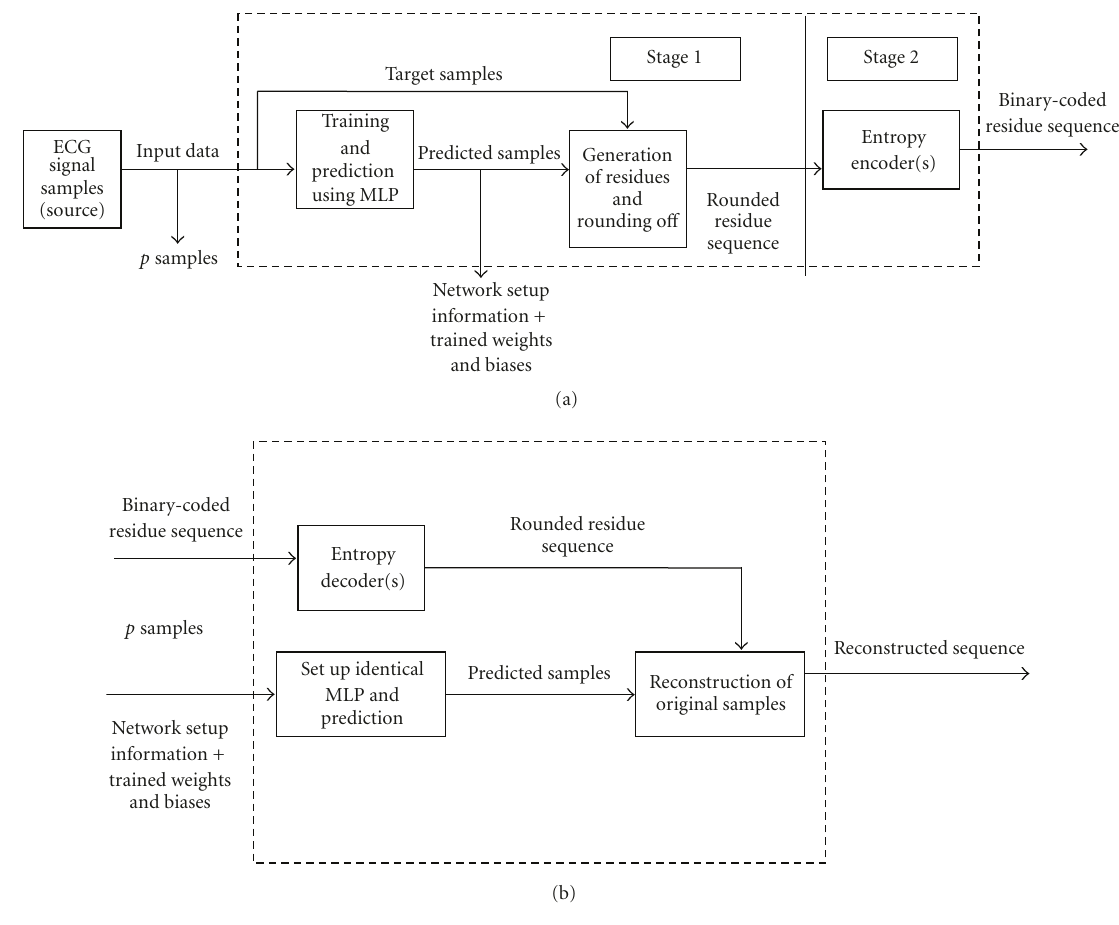
Figure 1: Lossless compression method: (a) transmitting end and (b) receiving end.